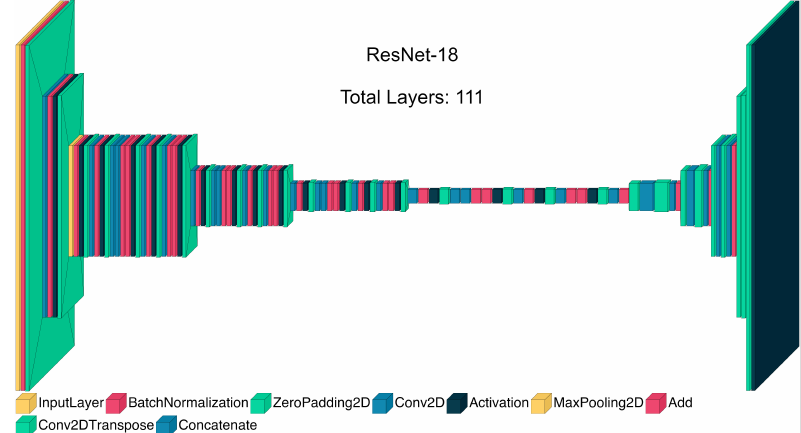
Figure 4. ResNet architecture for semantic